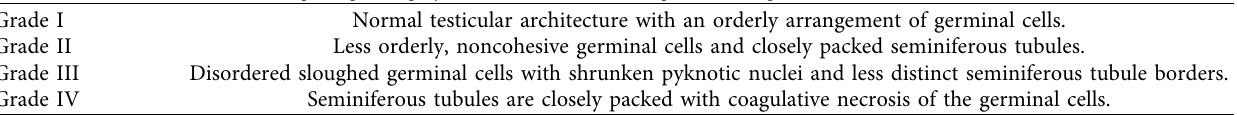
Table 1: Histological grading system of testicular damage according to the Cosentino ∗ classification. Grade I Normal testicular architecture with an orderly arrangement of germinal cells.